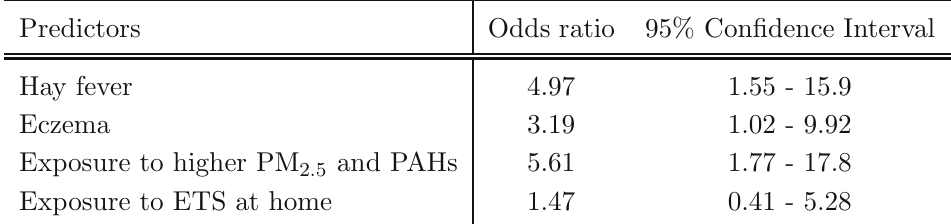
Table 5 Odds ratio for wheezing whenever and category of personal exposure to fine particles and PAHs accounted for hay fever, eczema and ETS exposure. Estimated from logistic regression (without subjects with confirmed asthma by medical